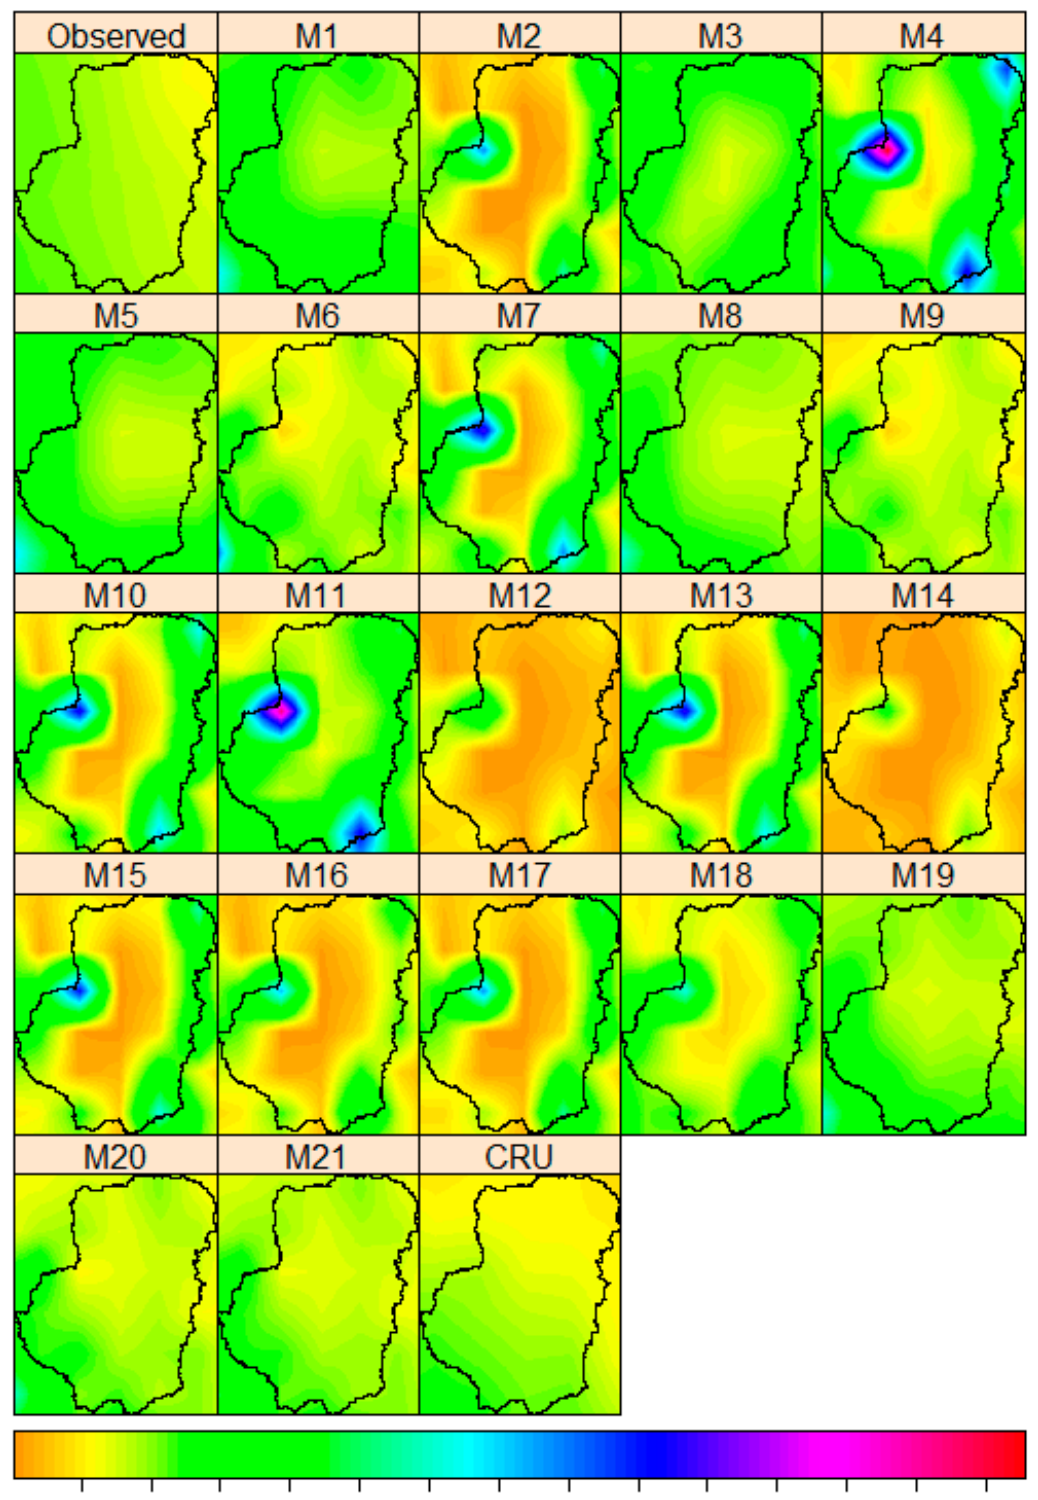
Figure 8. Spatial distribution of mean annual rainfall (in mm) from observed data, all climate models, their ensembles, and CRU data over the period of 1986–2005.